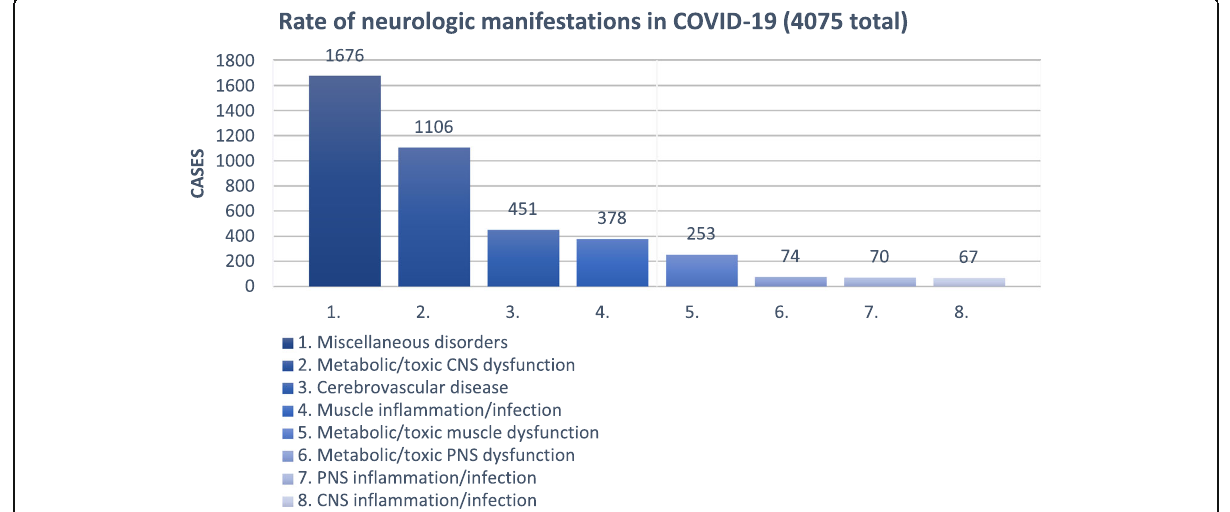
Fig. 3 Rate of neurologic manifestations in COVID-19 (4075 in